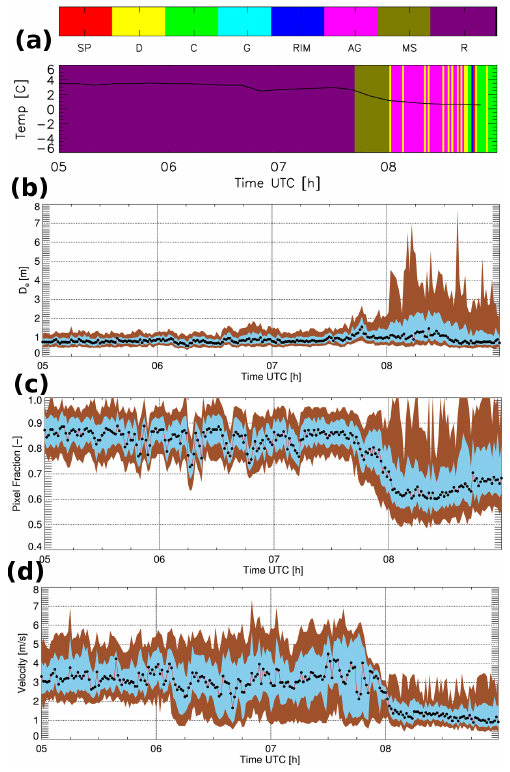
Figure 11. As in Fig. 9 but for 5 August 2010.